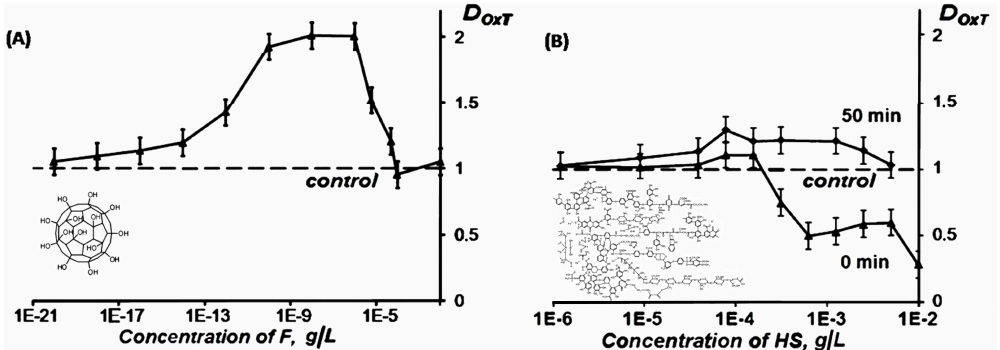
Figure 12. Antioxidant coefficients D OxT of F ( A ) and HS ( B ) in a model solution of organic oxidizer (1,4-benziquinone) [100]. The time of incubation of HS with the oxidizer (0 min and 50 min) is indicated in (B). Enzymatic assay.